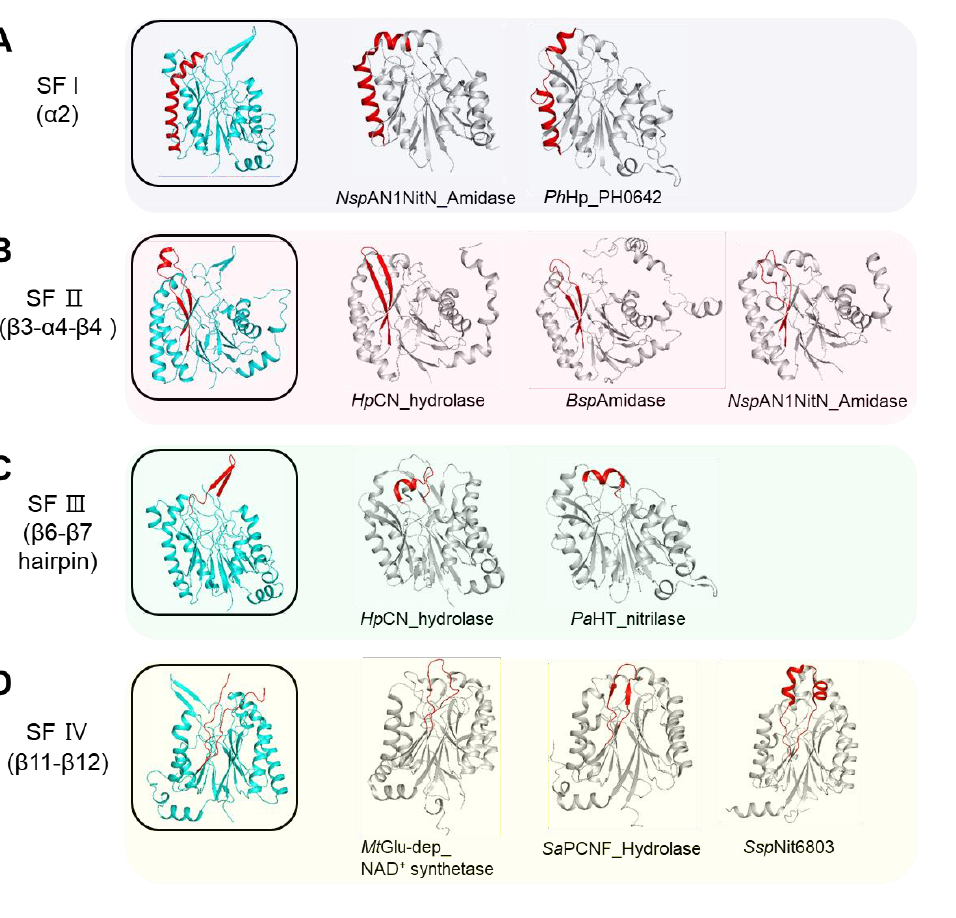
Figure 8. Five distinct structural features. ( A ) The representative structures containing structural feature I (SF I) according to the α2 helix. The KlNit2 structure is colored in cyan within a black rectangular box. The two structural homologs with a different conformation of the α2 helix are shown in gray. The α2 helix is shown in red. The two homologous structures indicate the follow- ing: NspAN1NitN_Amidase: NitN amidase from Nesterenkonia sp. AN1 (PDB code, 5JQN); PhHp_PH0642: Hypothetical Protein PH0642 from Pyrococcus horikoshii (PDB code, 1J31). ( B ) The representative structures containing structural feature II (SF II) according to the β3–α4–β4 motif based on KlNit2. The KlNit2 structure is colored in cyan within a black rectangular box. The three